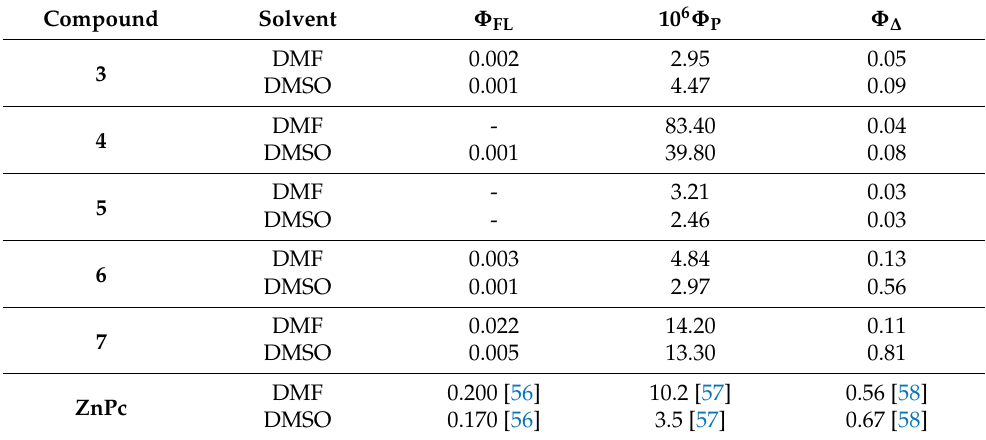
Table 2. Fluorescence, photobleaching and singlet oxygen formation quantum yields for the studied